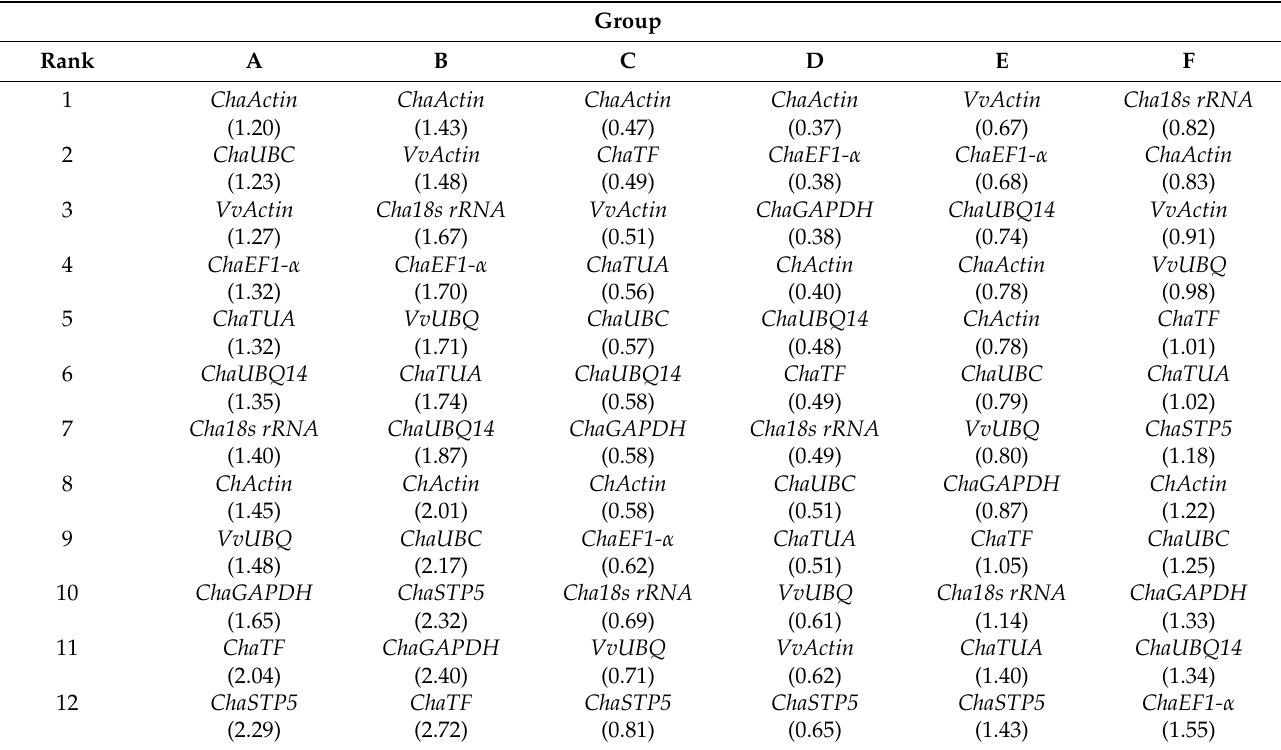
Table 6. Stability value (mean SD) rankings for 12 candidate reference genes according to Delta Ct analysis.